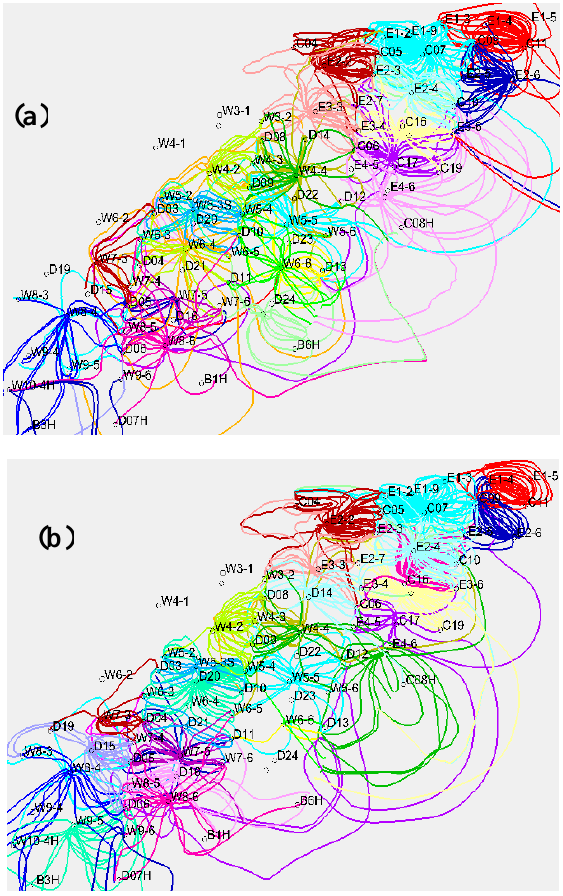
Figure 9. The streamline field of the ( a ) initial and ( b ) injected polymer 0.1 PV in the water / polymer flooding stage.